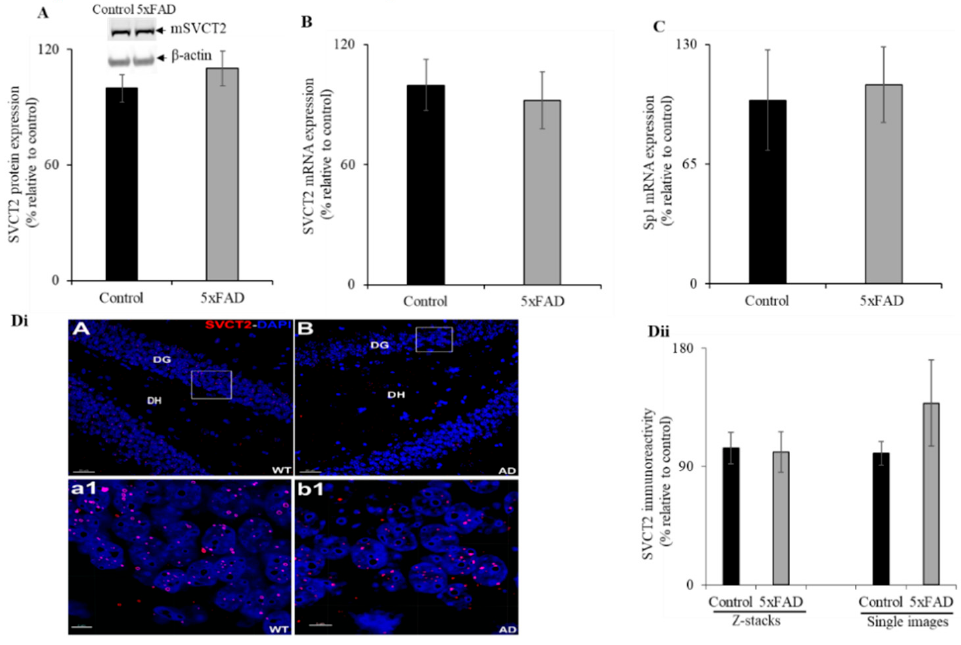
Figure 6. Expression levels of mSVCT2 protein, mRNA, and nuclear factor (Sp1) in 5xFAD mice hippocampus. ( A ) Western blot was performed using hippocampus protein (60 µ g) samples isolated from 5xFAD and WT littermates as described in “Methods”. The blots were probed with mouse SVCT2 antibodies. ( B , C ) RT-qPCR was done using SVCT2 or Sp1 primers and cDNA synthesized from mouse hippocampus RNA samples. ( Di ) Immunohistochemistry was performed using 5xFAD and WT littermate mouse hippocampus sections and SVCT2 antibody as described in “Methods” and representative low-magnification image displayed (Di A-B , DG—dentate gyrus, DH—dentate hilus; these are hippocampal sub-regions; scale bar 30 µ m). The highlighted (white box) regions of the 5xFAD (Alzheimer’s disease, AD) and WT were the high-magnification images, respectively (Di a1-b1 , scale bar 5 µ m). ( Dii ) Volumetric quantification of the SVCT2 immunoreactive puncta in the 5xFAD and WT littermates. Values are means ± SE of at least five mice ( n = 5–12) samples.